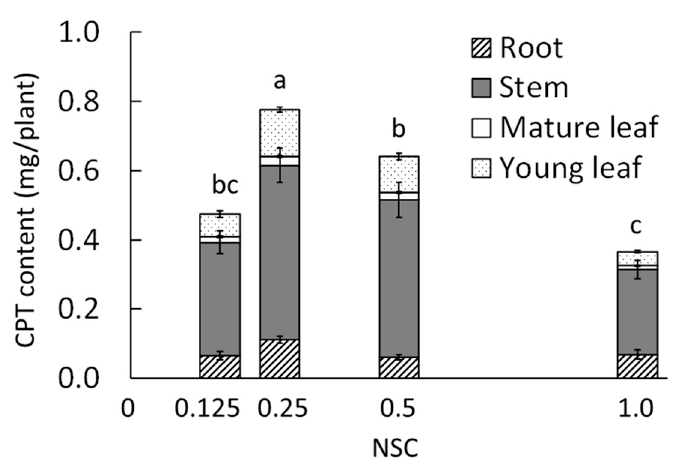
Figure 5. Effects of nutrient solution concentration (NSC) on the camptothecin (CPT) content in the whole O. pumila plant at 63 days after the start of the treatment in experiment 1. The treatments were 0.125, 0.25, 0.5, and 1.0 NSC. The CPT content was calculated using the CPT concentration determined by HPLC and the dry weight of each organ. Vertical bars indicate S.E. ( n = 8). Different letters indicate significant differences among the treatments at p < 0.05 by Tukey–Kramer’s test.